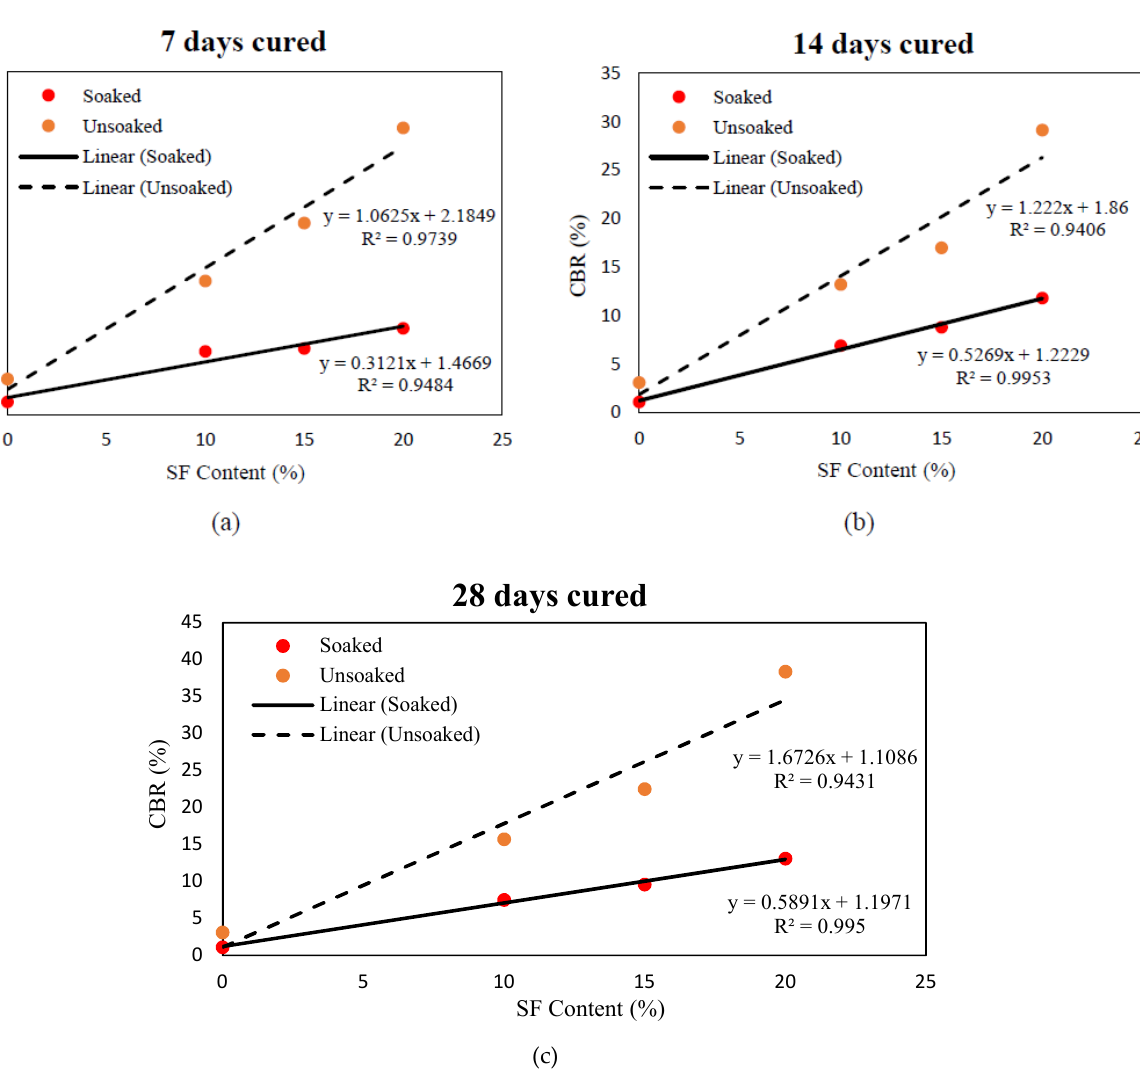
Figure 15. Statistical relationship between increasing amounts of SF and CBR (soaked and unsoaked) obtained after 7 ( a ), 14 ( b ), and 28 ( c ) days of curing. Table 7. Statistical analysis results for the verification of the variable similarity of CBR values (soaked and unsoaked) of 7, 14, and 28 days of